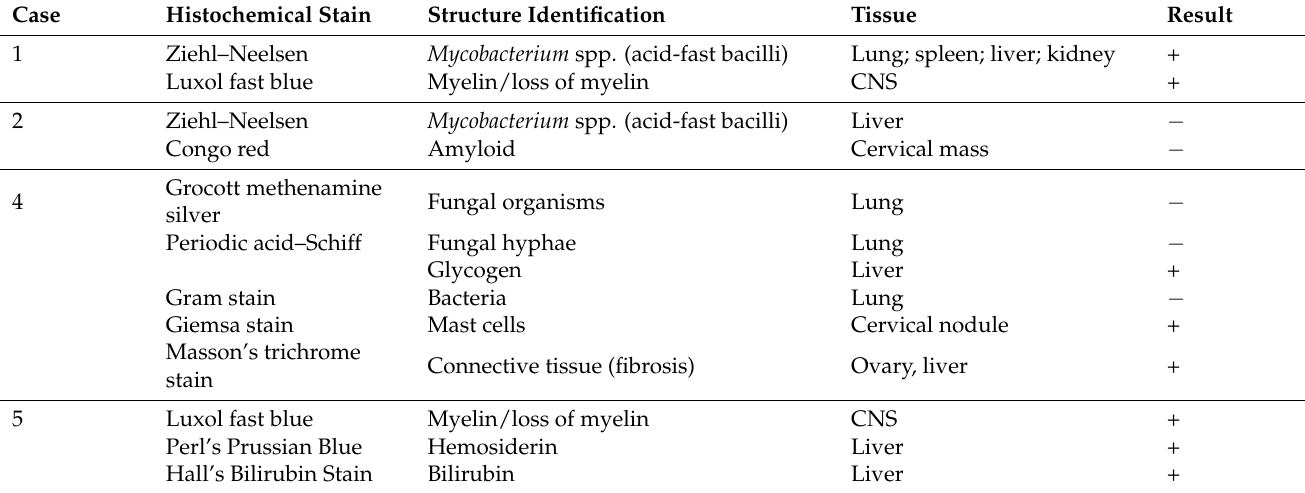
Table 3. Commonly used special stains.